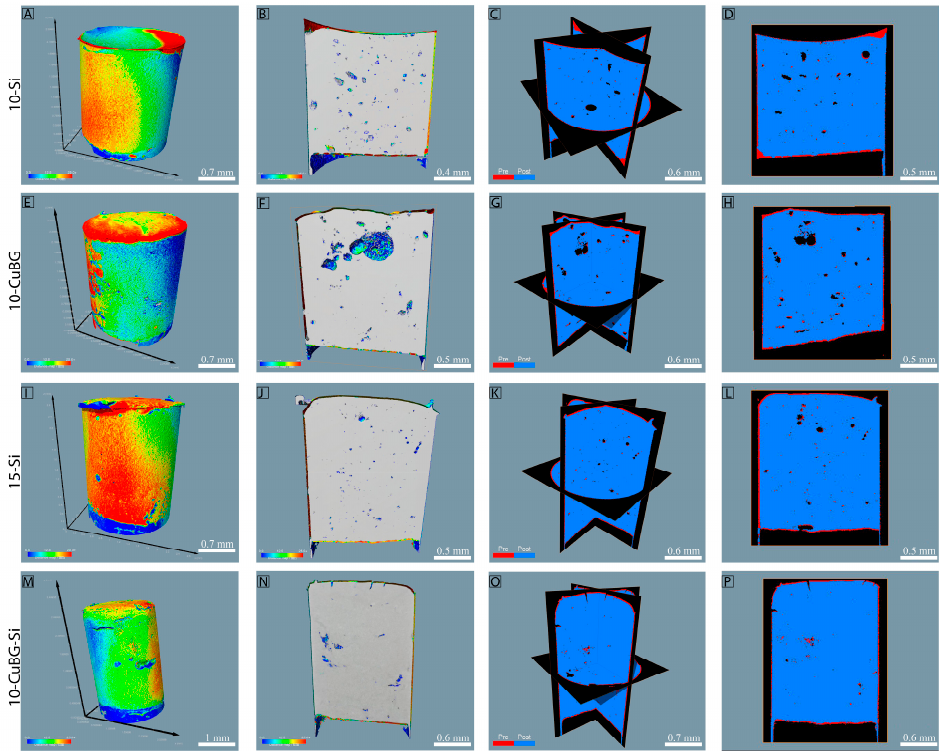
Figure 6. Superimposed nano-CT images and reconstruction of experimental composites containing binary and ternary fillers. ( A , E , I , M ) shows composite specimens with overlaid dimensional changes before and after polymerization, labeled nano-CT image overview. ( B , F , J , N ) represents the cross-sectional images, showing the pre- and post-polymerization areas of composites given in ( A , E , I , M ). The cross-sectional images of composites (given in ( A , E , I , M )) that show the dimensions of the samples before (red) and after (blue) polymerization are represented in ( C , D , G , H , K , L , O , P ). The presented images are superimposed images of before and after curing experimental composites.